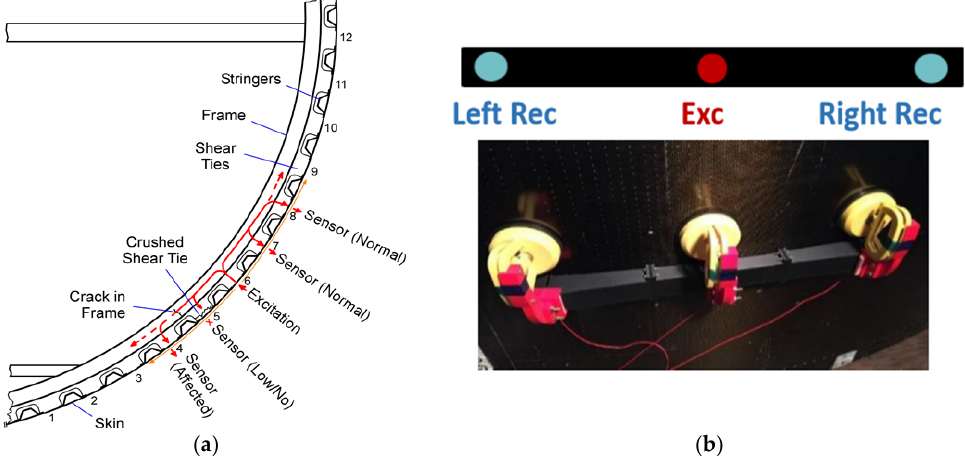
Figure 2. ( a ) Schematic of the ultrasonic guided waves (UGW) approach for the aerospace panel inspection; ( b ) differential scheme for contact inspection.